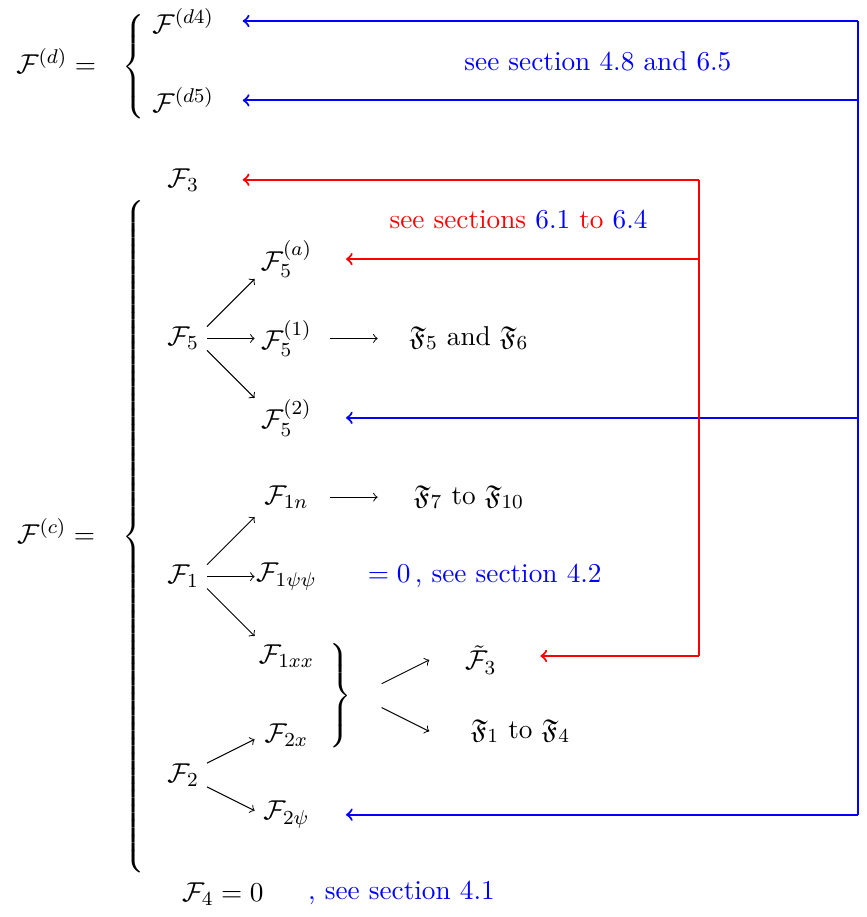
Figure 1 . Overview of the components F 1 , · · · F 5 and F ( d 4) , F ( d 5) , their partial cancellations, and the origin of the contributions F to the chiral amplitude. The text and arrows in blue and 1 , · · · , F 10 red refer to cancellations discussed in sections 4 and 6,